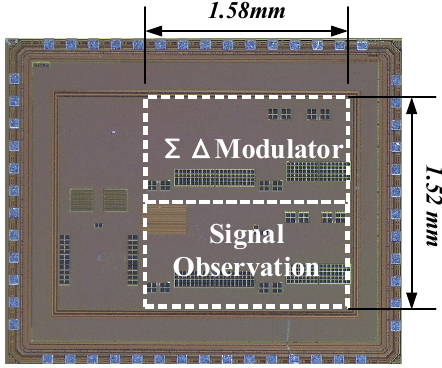
Figure 12. Microphotograph of the ΣΔ modulator with signal observation.